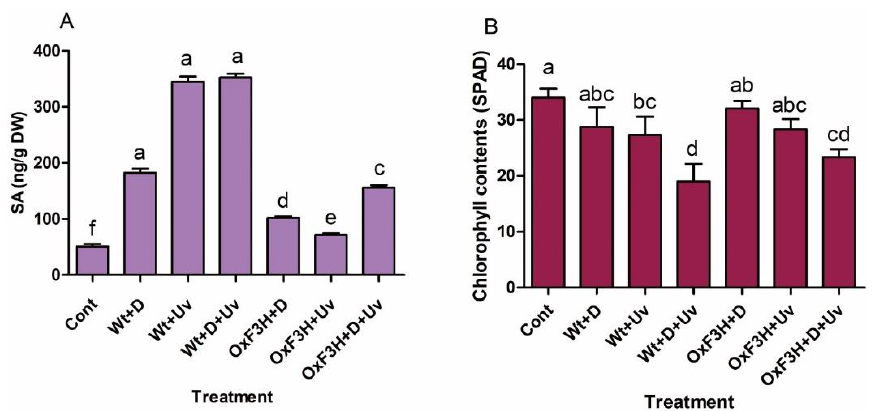
Figure 7. Salicylic acid and chlorophyll content are differentially regulated in wild and transgenic rice plants during drought and UV-B radiation stresses. ( A ) Salicylic acid and ( B ) chlorophyll content accumulation in wild and transgenic plants. Each data point is the mean of three replicates. Error bars represent standard errors. The bars shown with different letters are significantly different from each other as evaluated by DMRT analysis.